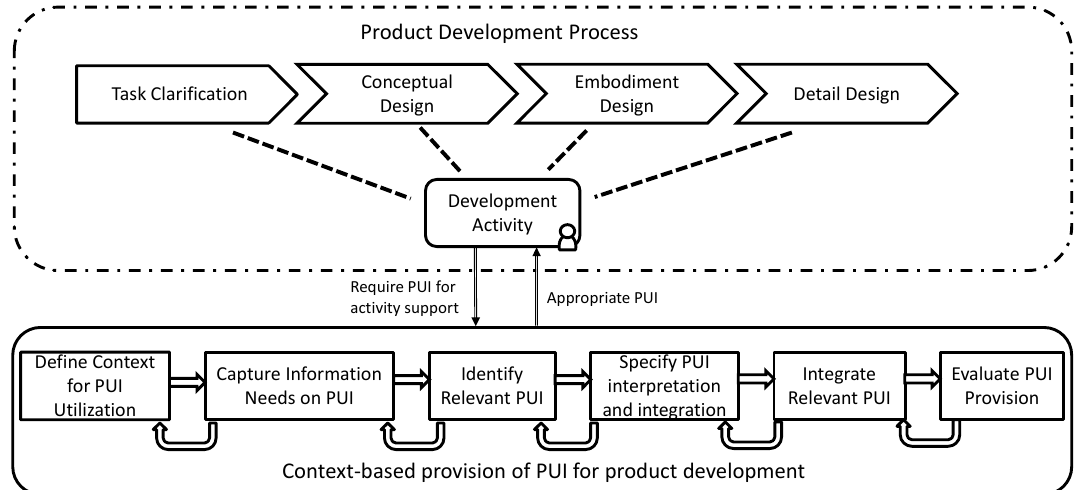
Figure 2. Methodology for context-based PUI provision.